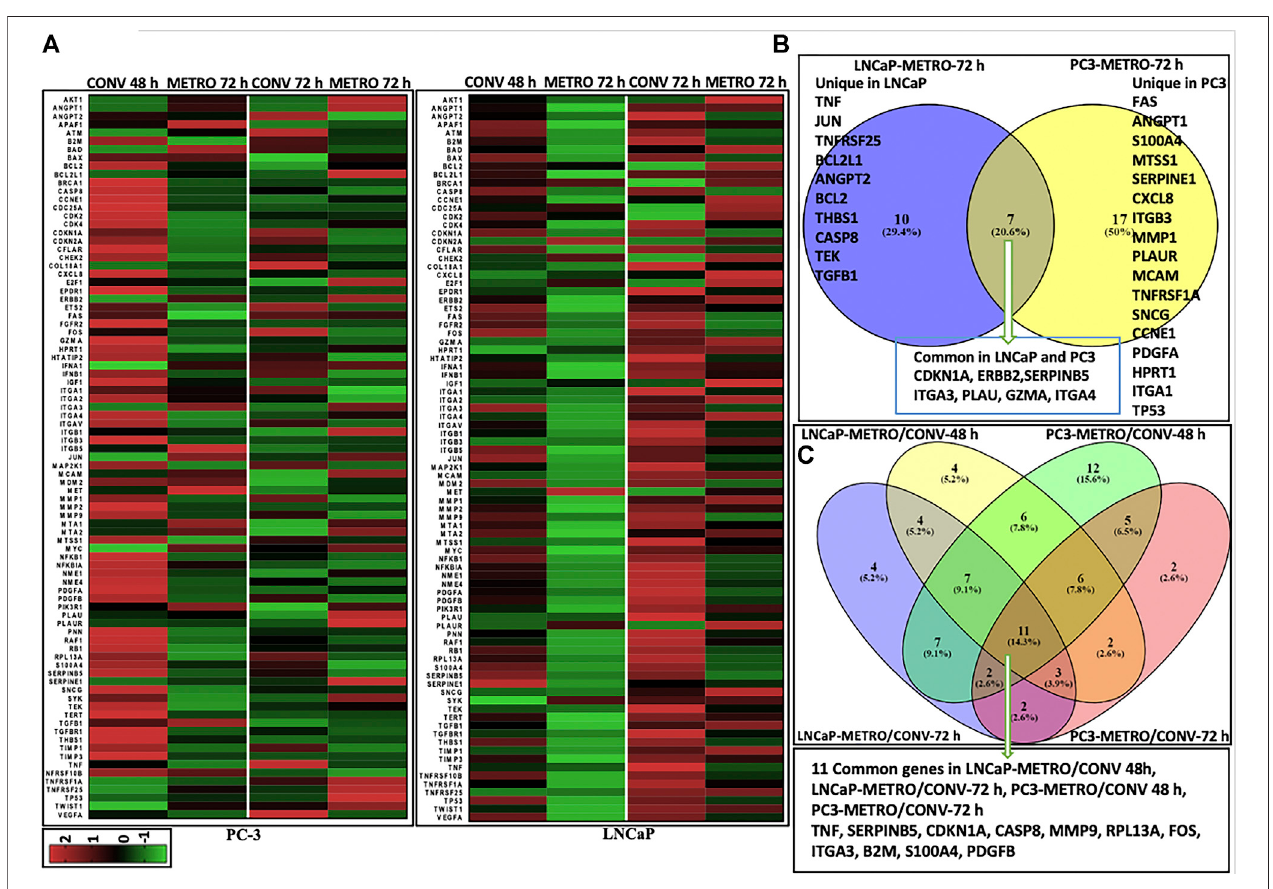
FIGURE 2 | Differential gene expression results Heatmaps representing differential gene (mRNA) expression between CONV vs METRO Topotecan treatment in PC-3 and LNCaP cell lines. Each row corresponds to one differentially expressed gene (DEG) ordered alphabetically. Each column represents a single representative sample. Log 2 ratios are depicted in a color scale where red represents upregulation and green represents downregulation (fold change cut-off value > 2). (A) DEGs for CONV and METRO TOPO treatments for I) PC-3 and II) LNCaP cell lines. Gene expression levels were assessed by RT-PCR (RT Pro fi ler ™ PCR Array Human Cancer PathwayFinder (PAHS-033A) array, QIAGEN; total number of genes ( n ) (cid:1) 91; including three control; housekeeping genes – GAPDH, ACTB, HGDC). Gene expression was calculated by ΔΔ Ct method: i) Delta Ct (cid:1) Ct Target gene- Ct Control gene (Beta actin; ACTB). ii) Expression in treatment groups were normalized to correspondingcontrol(nodrugtreatmentforbothPC-3andLNCaPcellline.VenndiagramsrepresentuniqueandcommonDEGsformetronomictreatmentinPC-3and LNCaP. (B) Post METRO treatment unique and commonly expressed gene pro fi le. I) 17 Unique DEGs for METRO treatment in PC-3; 10 Unique DEGs for METRO treatmentinLNCaP;7genes(CDKN1A,ERBB2,SERPINB5, ITGA3,PLAU,GZMA andITGA4)wereexpressed commonlyinboth celllines(PC-3and LNCaP)following METRO TOPO treatment. II) Top DEGs were ( n (cid:1) 11) TNF, SERPINB5, CDKN1A, CASP8, MMP9, RPL13A, FOS, ITGA3, B2M, S100A4 and PDGFB when all the treatment groups were considered together for all the cell lines (CONV and METRO at 48 and 72 h treatment regimen in PC-3 and